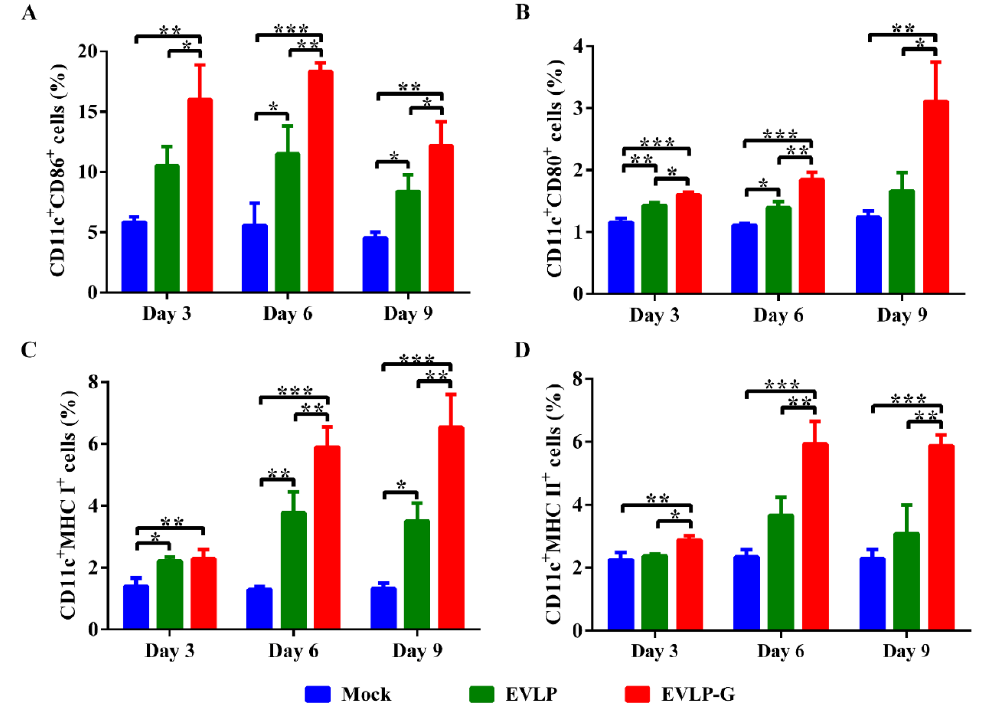
Figure 6. Flow cytometry assay of recruitment and/or activation of DCs in inguinal lymph nodes. The inguinal lymph nodes were collected from mice immunized with EVLP, EVLP-G and PBS ( n = 3) on 3, 6, and 9 days after the first immunization. The cells in lymph nodes were strained with mouse anti-CD11C, -CD80, -CD86, -MHC I, and -MHC II monoclonal antibodies. The double positive cells that CD11c + CD86 + ( A ); CD11c + CD80 + ( B ); CD11c + MHC I + ( C ); and CD11c + MHC II + ( D ) were plotted. The data represent the means of double positive cells percentage with SD and were analyzed by one-way ANOVA (* p < 0.05, ** p < 0.01, *** p <